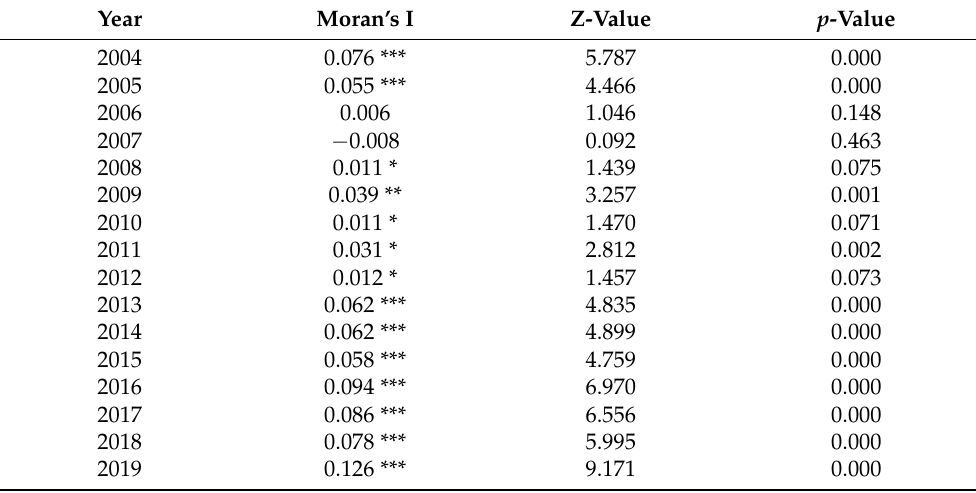
Table 3. Global spatial Moran’s I of